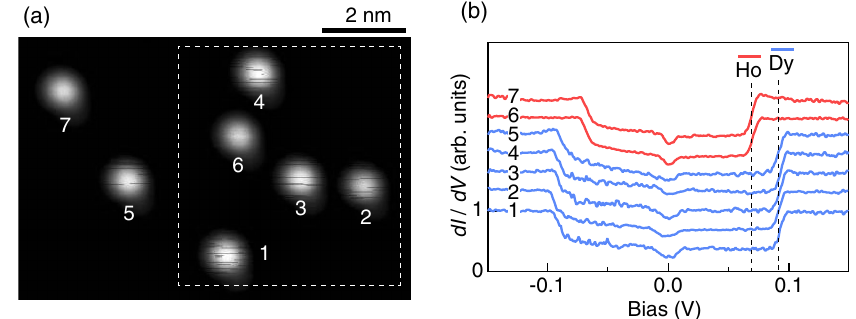
FIG. 3. Spin-polarized measurements on Dy and Ho on gr = Ir ð 111 Þ . (a) Constant current STM image showing the coexistence of Dy and Ho adatoms. The dashed white box identifies the region used for the video (see Ref. [53]). Parameters: V T ¼ 6 . 5 K. (b) dI=dV spectra acquired on Dy and Ho adatoms. The spectra are background corrected, normalized to 1, and vertically ¼ 100 pA, V ¼ − 0 . 15 V, V ¼ 5 mV peak-to-peak, T ¼ 6 . 5 K. All data were acquired using a offset for clarity. Parameters: I set set mod Mn 88 Ni 12